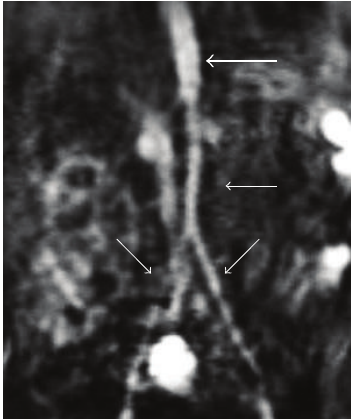
Figure 6: Coronal view of a postcontrast MRA of the abdomen demonstrates normal caliber of the abdominal aorta above the renal arteries (thick white arrow). There is symmetric narrowing of the abdominal aorta below the level of the renal arteries extending into the iliac arteries (thin white arrows). Of note, the beaded appearance of the iliac arteries is artifactual.